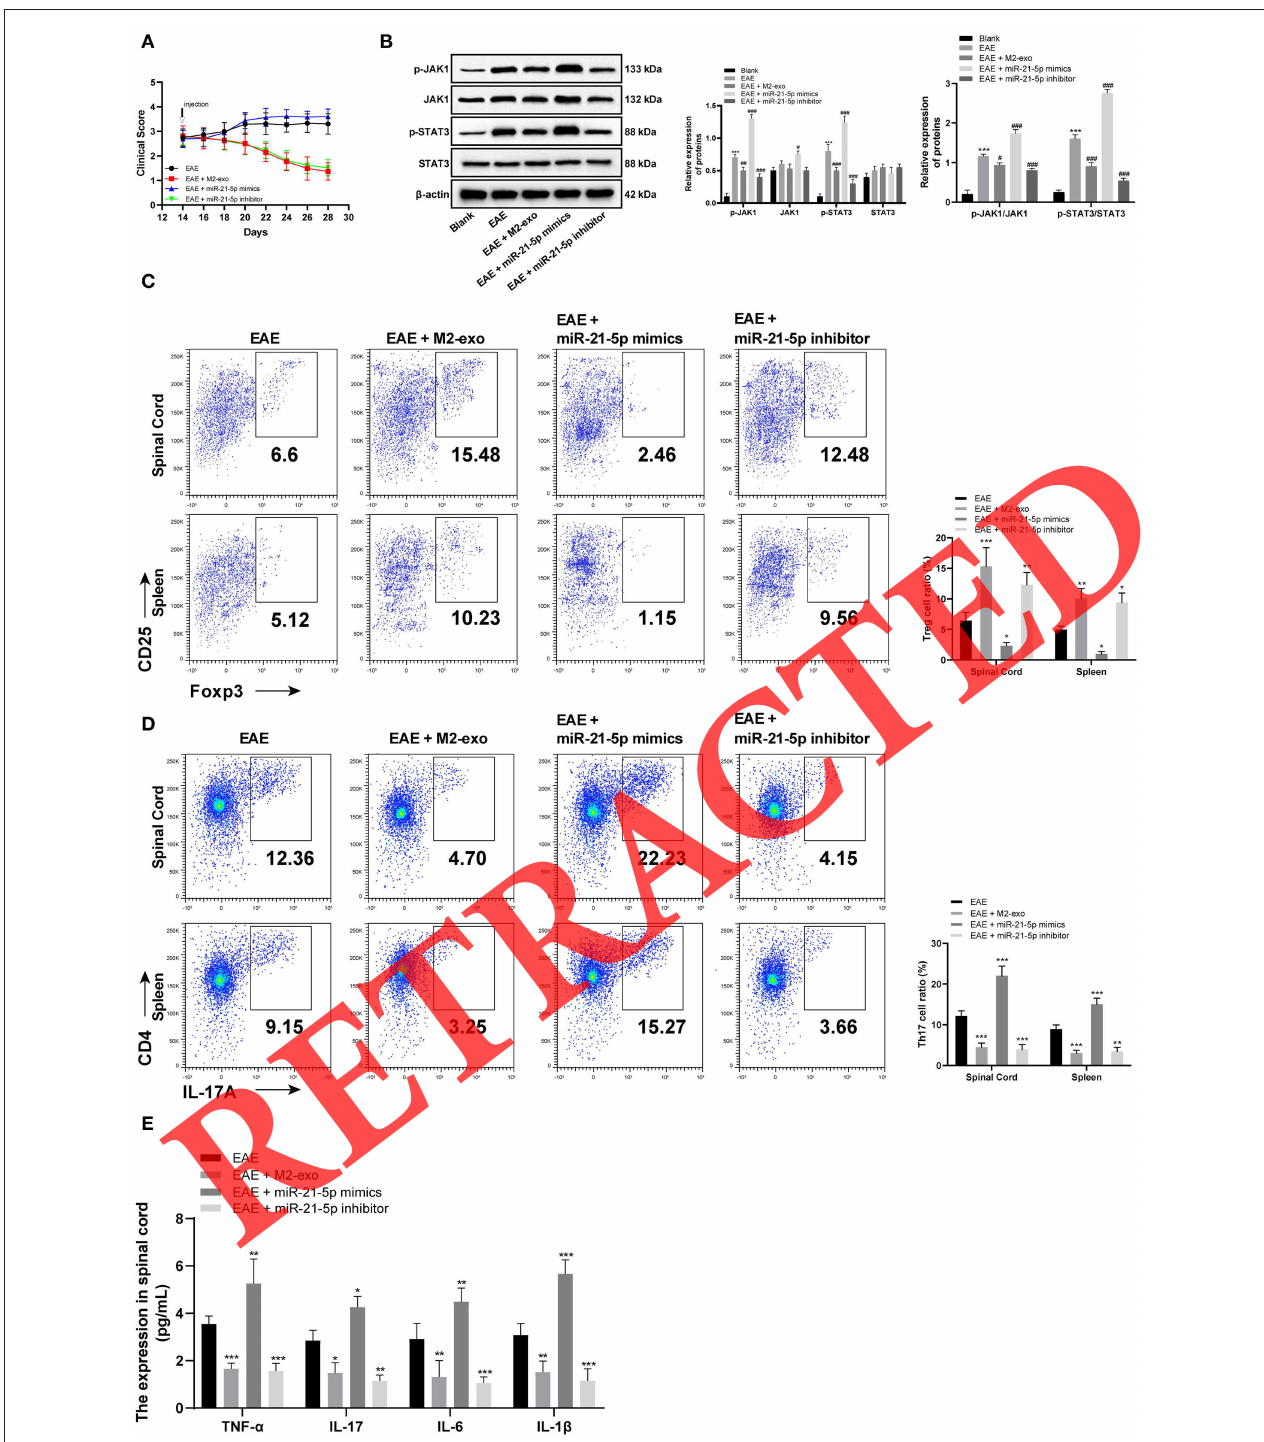
FIGURE 6 | SOCS5 alleviates EAE symptoms by inhibiting pro-inflammatory response of Th17 cells through the JAKs/STAT3 pathway. (A) Clinical scores of EAE mice with different treatment; (B) Levels of JAKs/STAT3 pathway-related proteins and their phosphorylation levels in EAE mice detected by western blot analysis; vs. the blank group, *** p < 0.001; compared with the EAE group, # p < 0.05, ## p < 0.01, ### p < 0.001; (C,D) Detection of Treg and Th17 cells in spinal cord cells and splenocytes by flow cytometry; compared with the EAE group, * p < 0.05, ** p < 0.01, *** p < 0.001; (E) Detection of inflammatory factors in spinal cord cells by ELISA; compared with the EAE group, * p < 0.05, ** p < 0.01, *** p < 0.001. Data are analyzed with two-way ANOVA, and Tukey’s multiple comparisons test was utilized for post hoc test n =